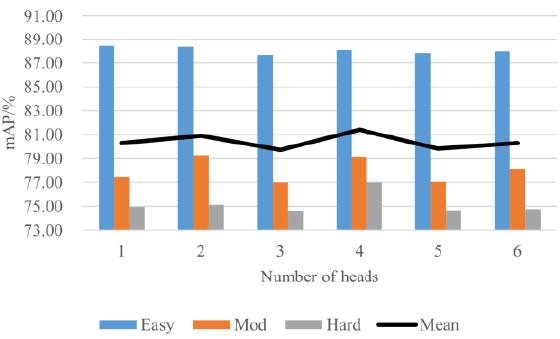
Figure 13. Performance comparison on the car category with different heads. Table 7. The suppression effect of fusion features under rain noise.